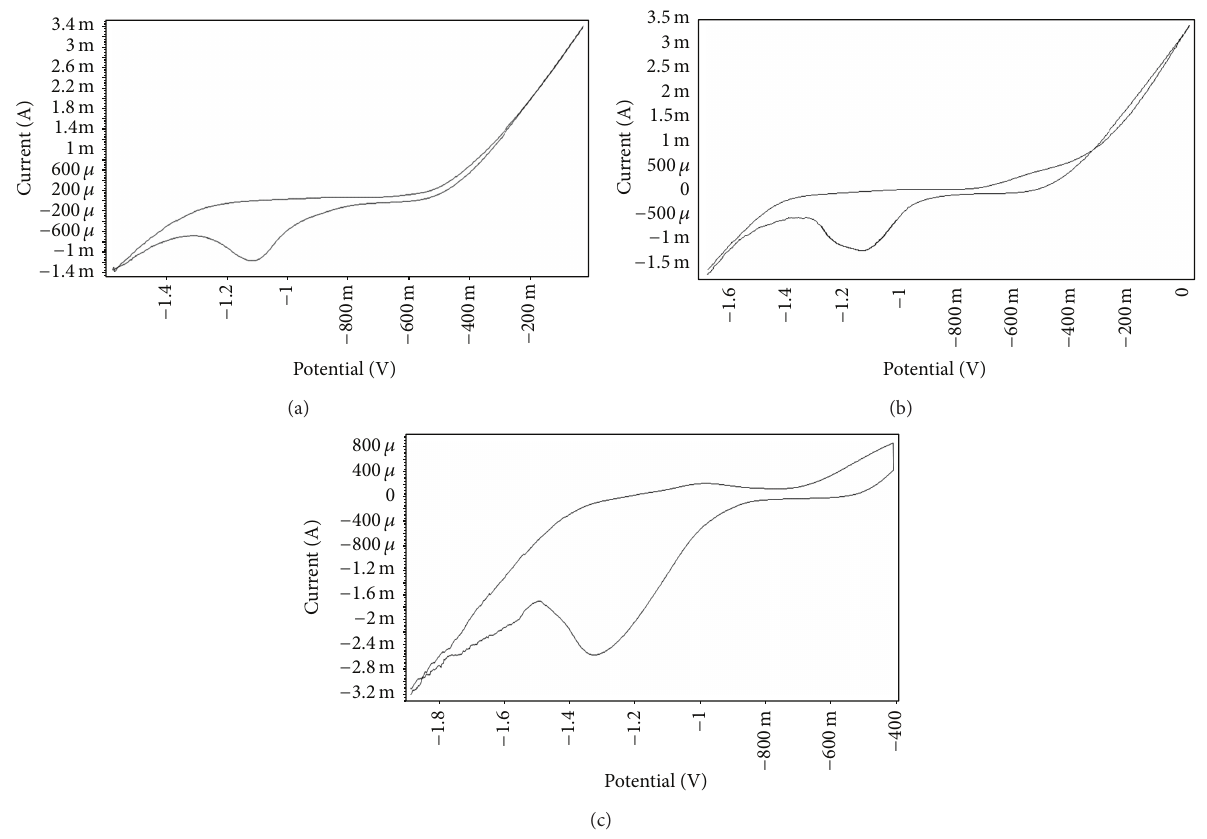
Figure 6: (a) Cyclic voltammogram of carbon steel immersed in 3.5% NaCl. (b) Cyclic voltammogram of carbon steel immersed in sea water for one day and (c) cyclic voltammogram of carbon steel electrode deposited with protective film.